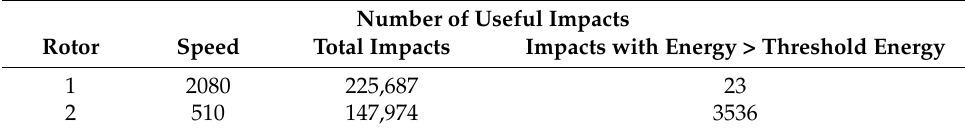
Table 4. Number of events and useful events at different rotor